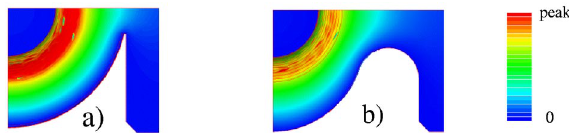
FIG. 1. (Color) Quarter cross section of (a) thin-irised coupler and (b) fat-lipped coupler with reduced surface magnetic field and ‘‘racetrack’’ cell